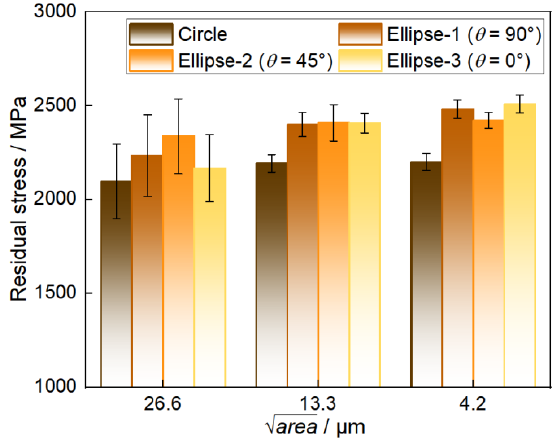
Figure 5. The average maximum residual stress calculated with different RVEs and the corresponding standard deviations.